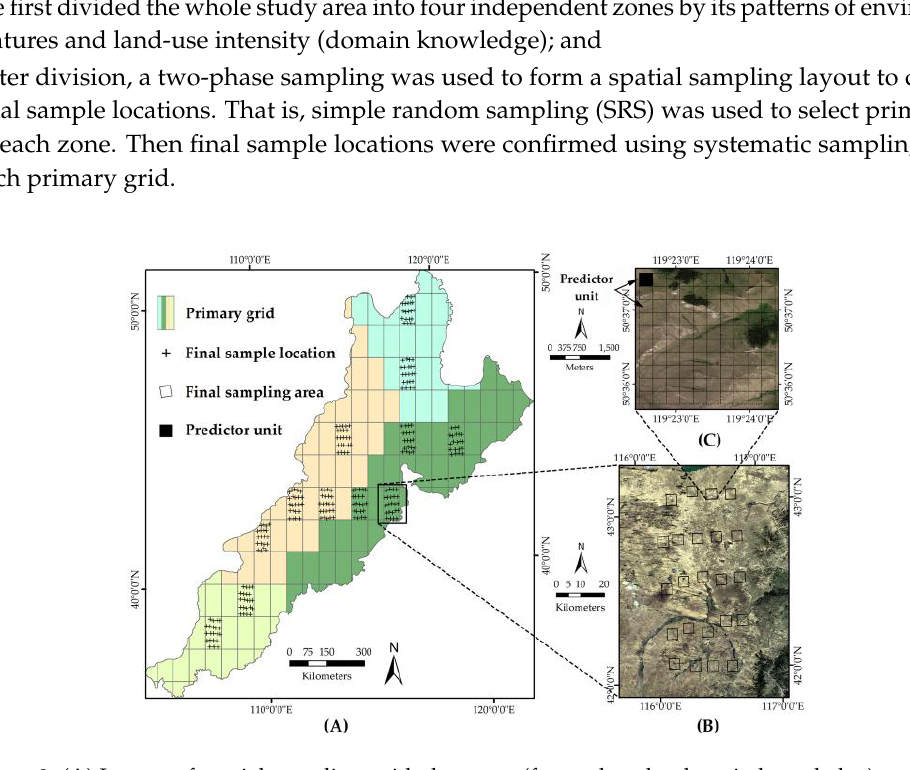
Figure 3. ( A ) Layout of spatial sampling, with the zones (four colors, by domain knowledge),